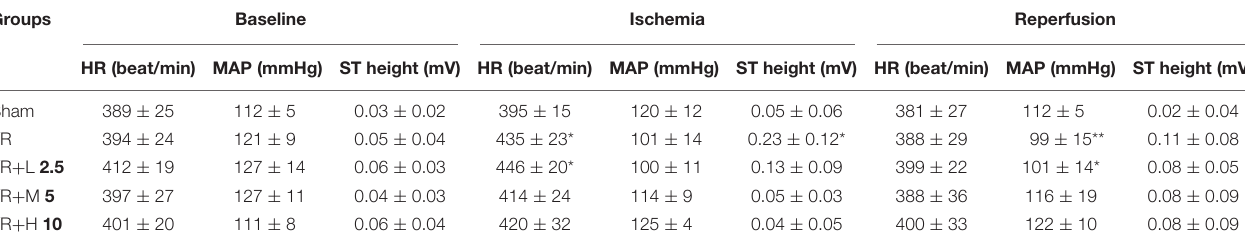
TABLE 1 | Effect of LS-102 on heart about the hemodynamic parameters. Groups Baseline Ischemia